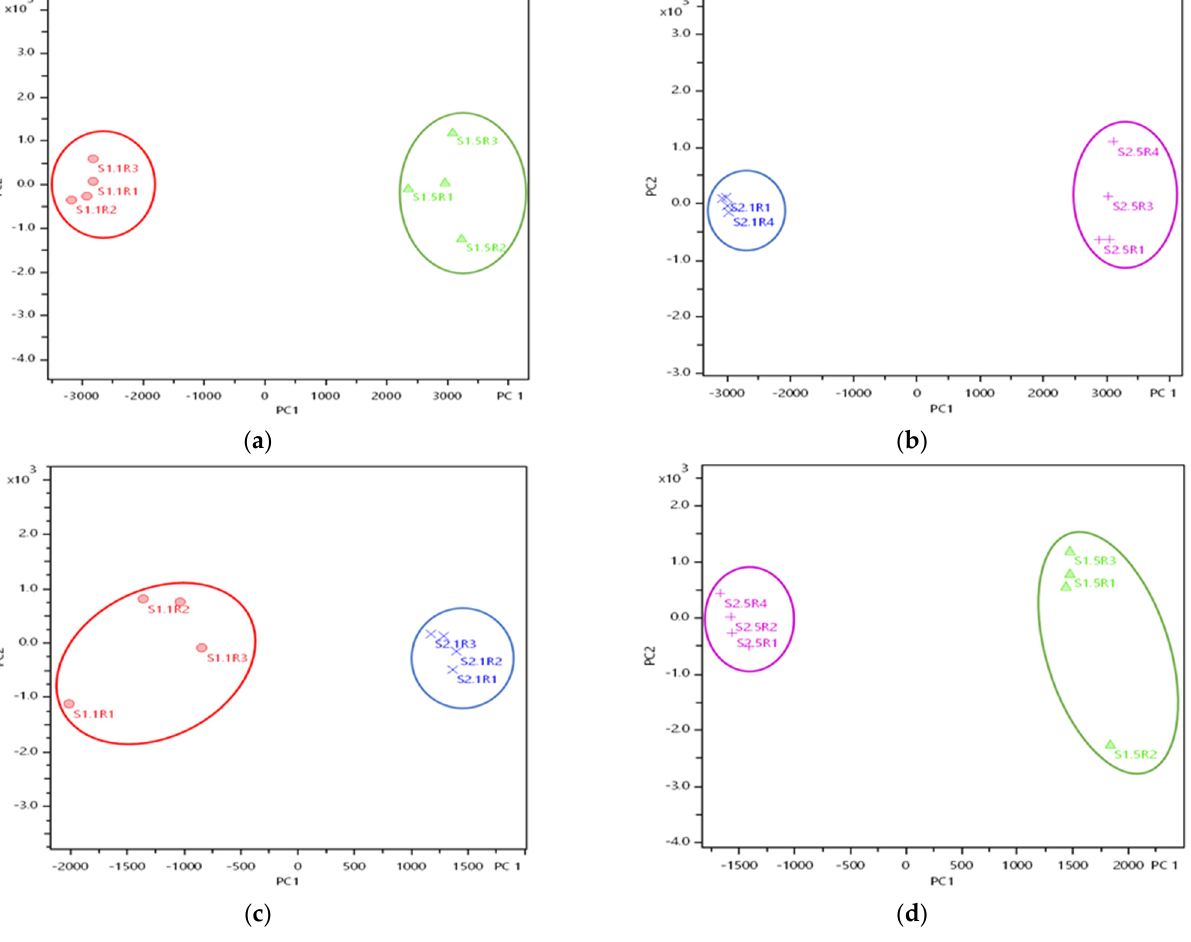
Figure 1. Comparison of ( a ) grapes and wine from site 1 (S1.1 vs. S1.5): PC1(90.8%), PC2(93.8%), R 2 (cum)=0.961, Q 2 (cum)=0.796; ( b ) grapes and wine from site 2 (S2.1 vs. S2.5): PC1(93%), PC2(95.3%), R 2 (cum)=0.848, Q 2 (cum)=0.796; ( c ) grapes from site 1 and site 2 (S1.1 vs. S2.1): PC1(60.1%), PC2(75.4%), R 2 (cum)=0.879, Q 2 (cum)=0.569; and ( d ) wine from site 1 and site 2 (S1.5 vs. S2.5): PC1(71.2%), PC2(77.4%), R 2 (cum)=0.98, Q 2 (cum)=0.671. Principal component analysis (PCA). Where the replicates (R) are similar, the label cannot be discriminated in the figures. Table 3. Putative compounds identified using UHPLC-MS/MS in the negative mode. Retention time (RT), molecular formula and mass spectrometric data of the molecular ions and observed fragments of compounds present in all the